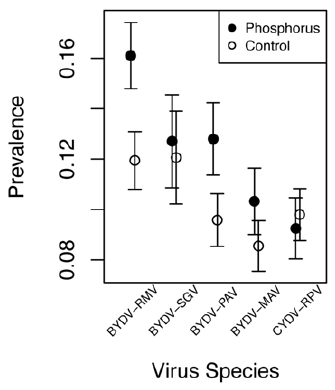
Figure 4. Effects of phosphorus addition on the prevalence of five viral species. Error bars represent 6 one SE from the mean.